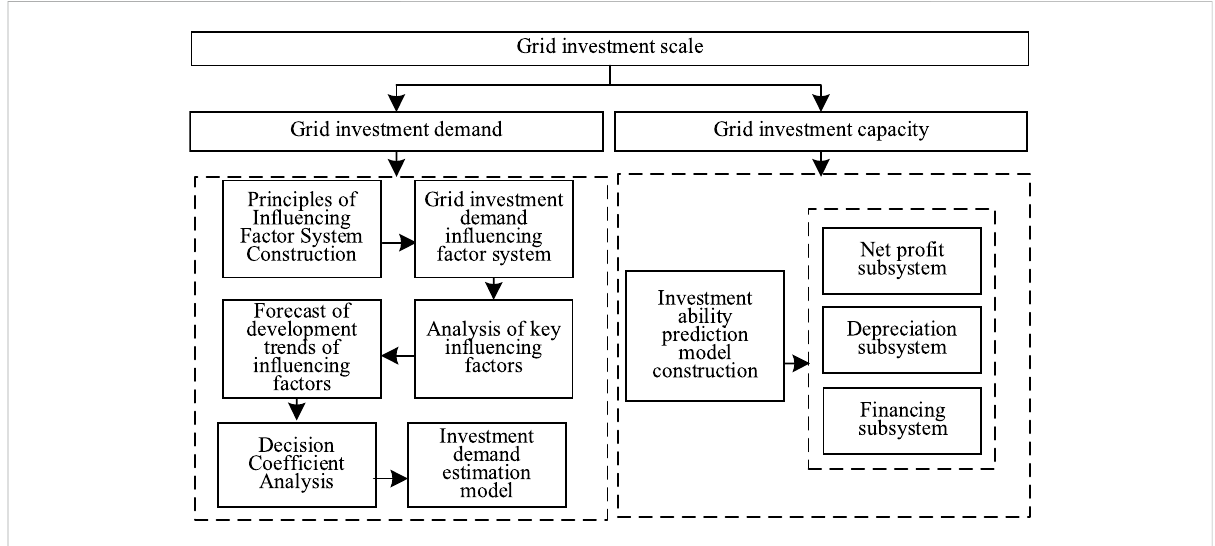
FIGURE 3 Calculation fl ow chart of investment scale of grid side in future years.